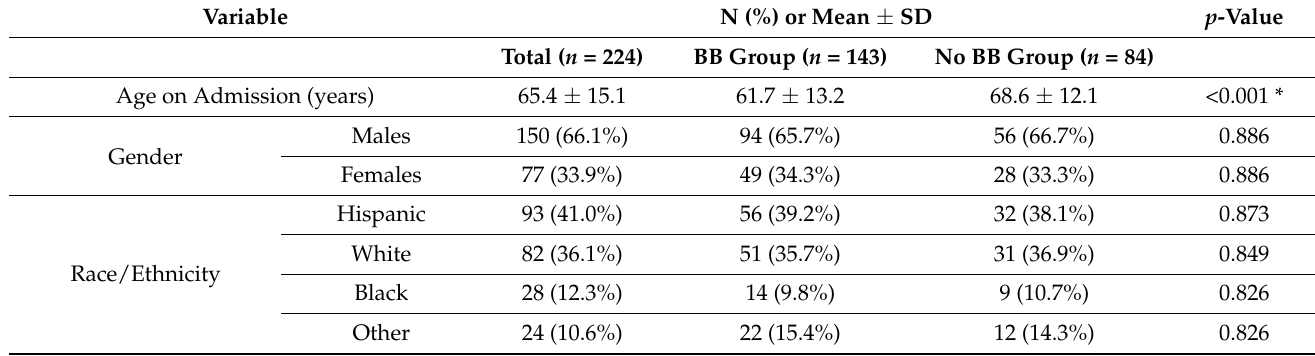
Table 1. Baseline characteristics for entire cohort, and separated by BB group vs. no BB